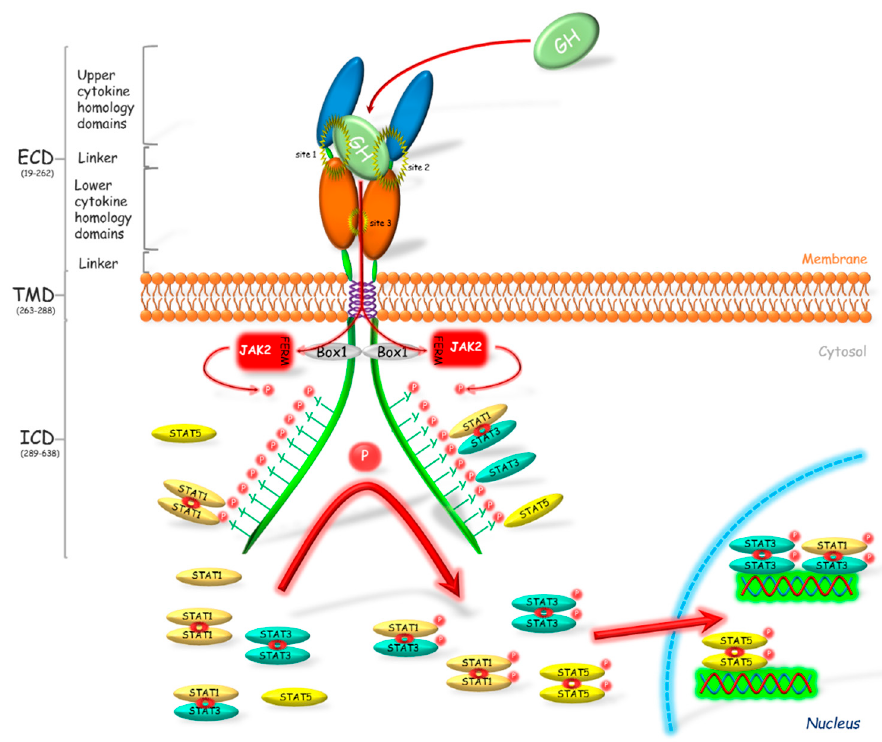
Figure 1. Activation of the growth hormone receptor and its signal transduction. Growth hormone (GH) binds to and activates its dimerized receptor (GHR). The activation leads to JAK2 binding via N-terminal 4.1, Ezrin, Radixin, Moesin (FERM) domain to Box 1 motif of the GHR and subsequently to phosphorylation of the intracellular tyrosine residues. The phosphotyrosines provide sites for binding of the various target signaling proteins including STATs, which in consequence leads to their phosphorylation. STATs are present in the cellular cytoplasm mostly in dimerized form. After phosphorylation STATs translocate into the nucleus where these transcriptional activators bind to appropriate promoter regions on DNA, which results in the transcription of gene or a set of genes.